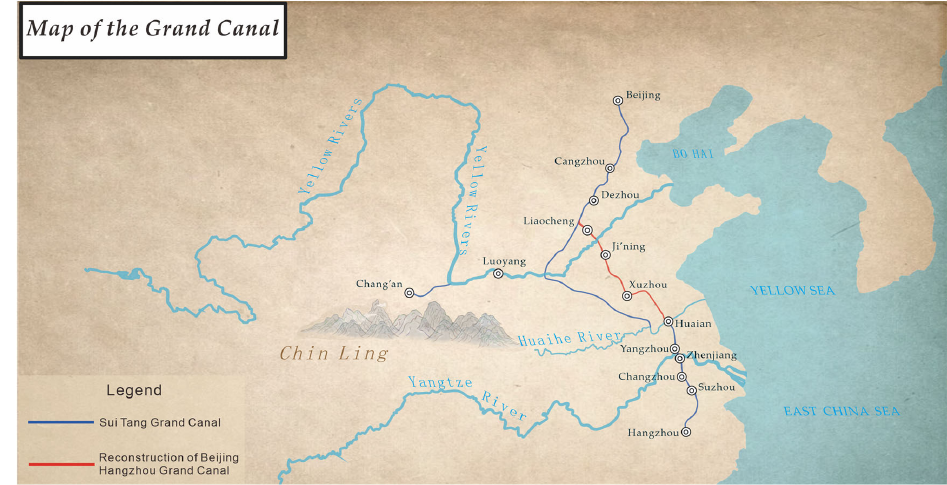
Figure 5. Map of the Grand Canal.